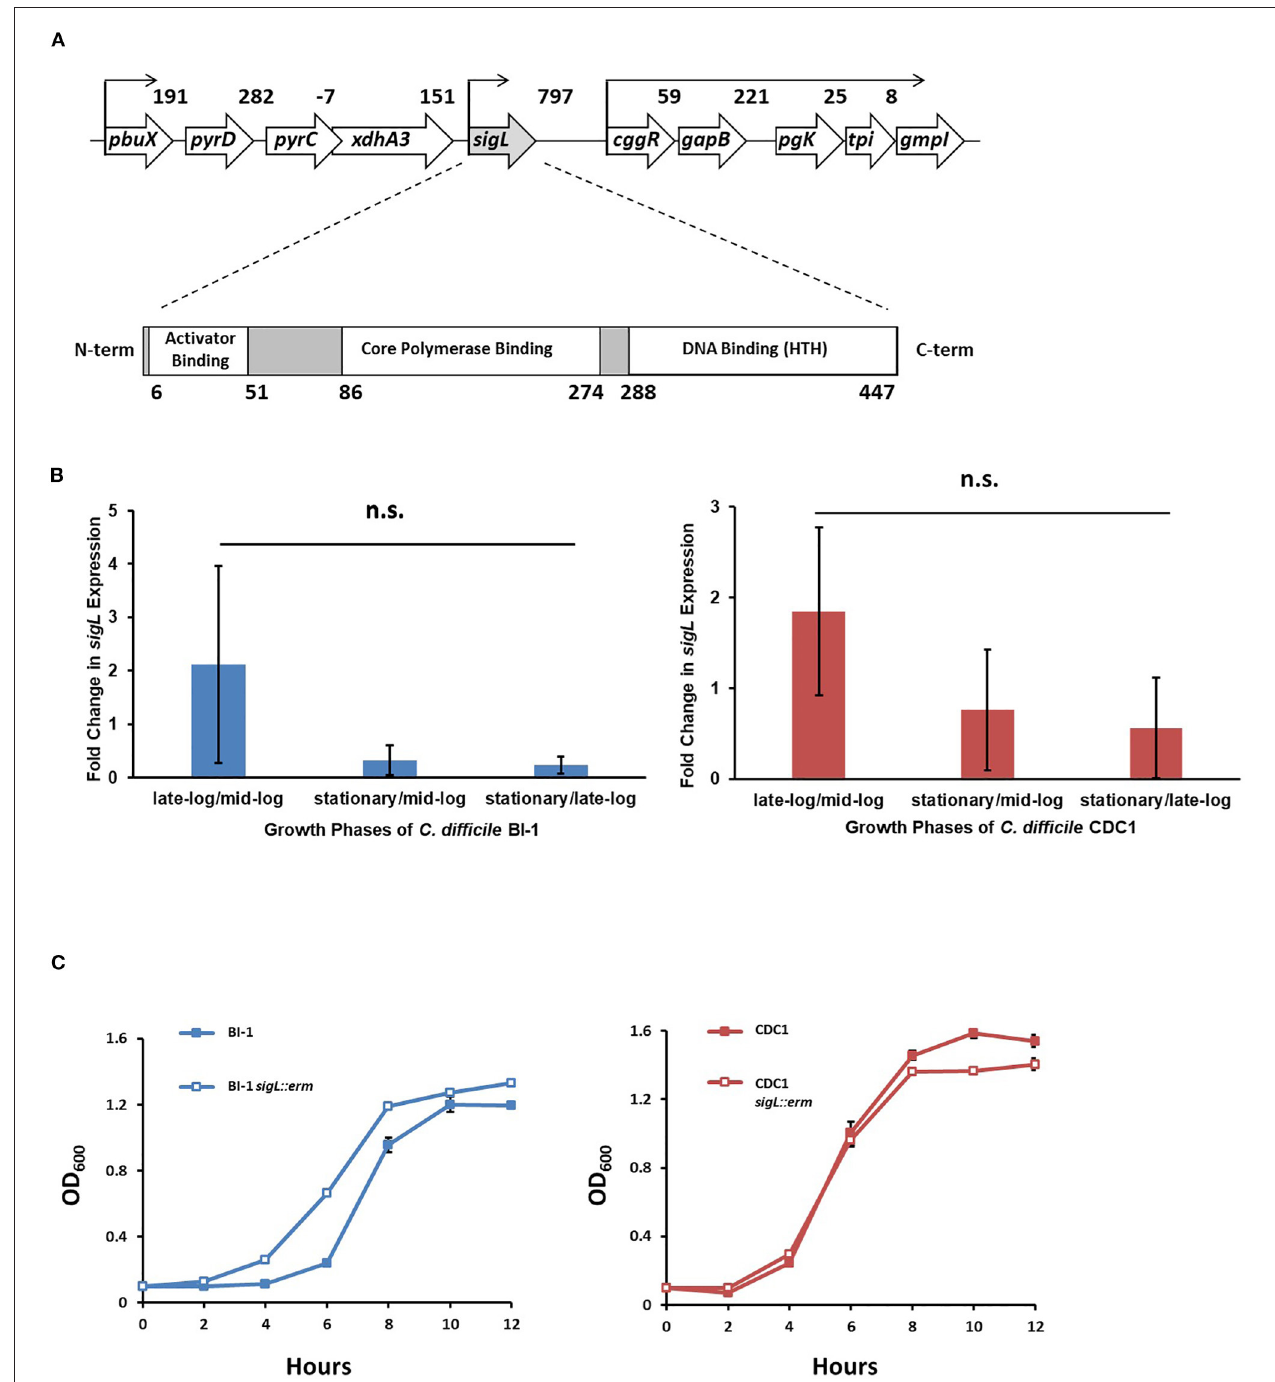
FIGURE 1 | sigL loci, expression, and growth kinetics in C. difficile BI-1 and CDC1. (A) C. difficile sigL locus, showing predicted promoters, based on strain BI-1 genome sequence, and SigL conserved binding domains. Numbers in the upper schematic represent intergenic distances, and numbers below the lower schematic indicate amino acids. (B) Quantitative RT-PCR of sigL in BI-1 and CDC-1 across multiple growth phases. 16s was used as a housekeeping control for qRT-PCR. Fold changes in expression represent the average of three biological replicates with standard deviation. n.s. = not significant (C) Growth of BI-1 and CDC1 strains compared to respective sigL::erm mutants. Cultures were grown in